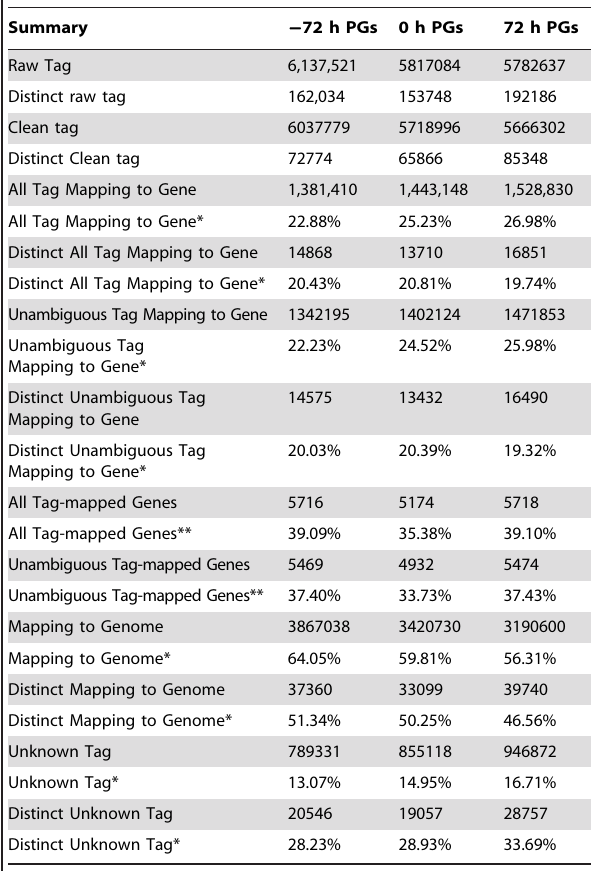
Table 1. Tag analysis statistics.